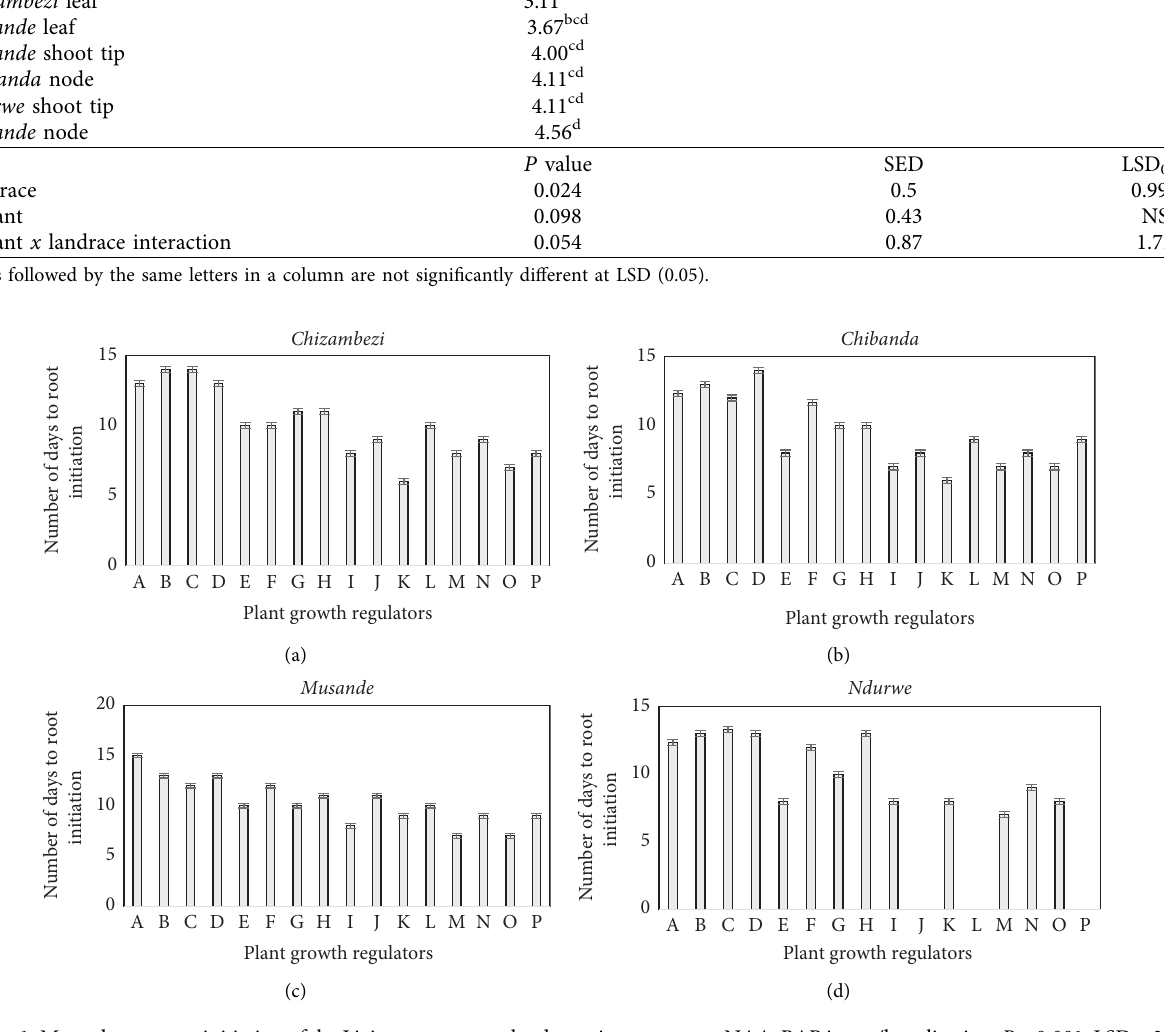
Figure 1: Mean days to root initiation of the Livingstone potato landraces in response to NAA: BAP in mg/l application. P < 0 . 001, LSD � 3.22. Error bars represent standard errors of the differences. Plant growth regulators key: A (0mg/l:0mg/l), B (0mg/l:0.5mg/l), C (0mg/l:1mg/l), D (0mg/l:2mg/l), E (0.2mg/l:0mg/l), F (0.2mg/l:0.5mg/l), H (0.2mg/l:2mg/l), I (0.5mg/l:0mg/l), J (0.5mg/l:0.5mg/l), J (0.5mg/l: 0.5mg/l), K (0.5mg/l:1mg/l), L (0.5mg/l:2mg/l), M (1mg/l:0mg/l), N (1mg/l:0.5mg/l), O (1mg/l:1mg/l), and P